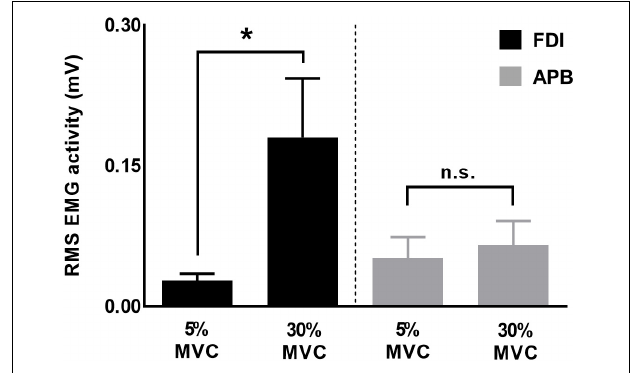
FIGURE 7 | EMG activity for FDI and APB muscles. Force magnitude- dependent modulation in EMG activity was significant for FDI but not for APB muscles. Data are averages of all subjects (vertical bars denote SE), asterisk indicates p = 0.019 and n.s. indicates p >